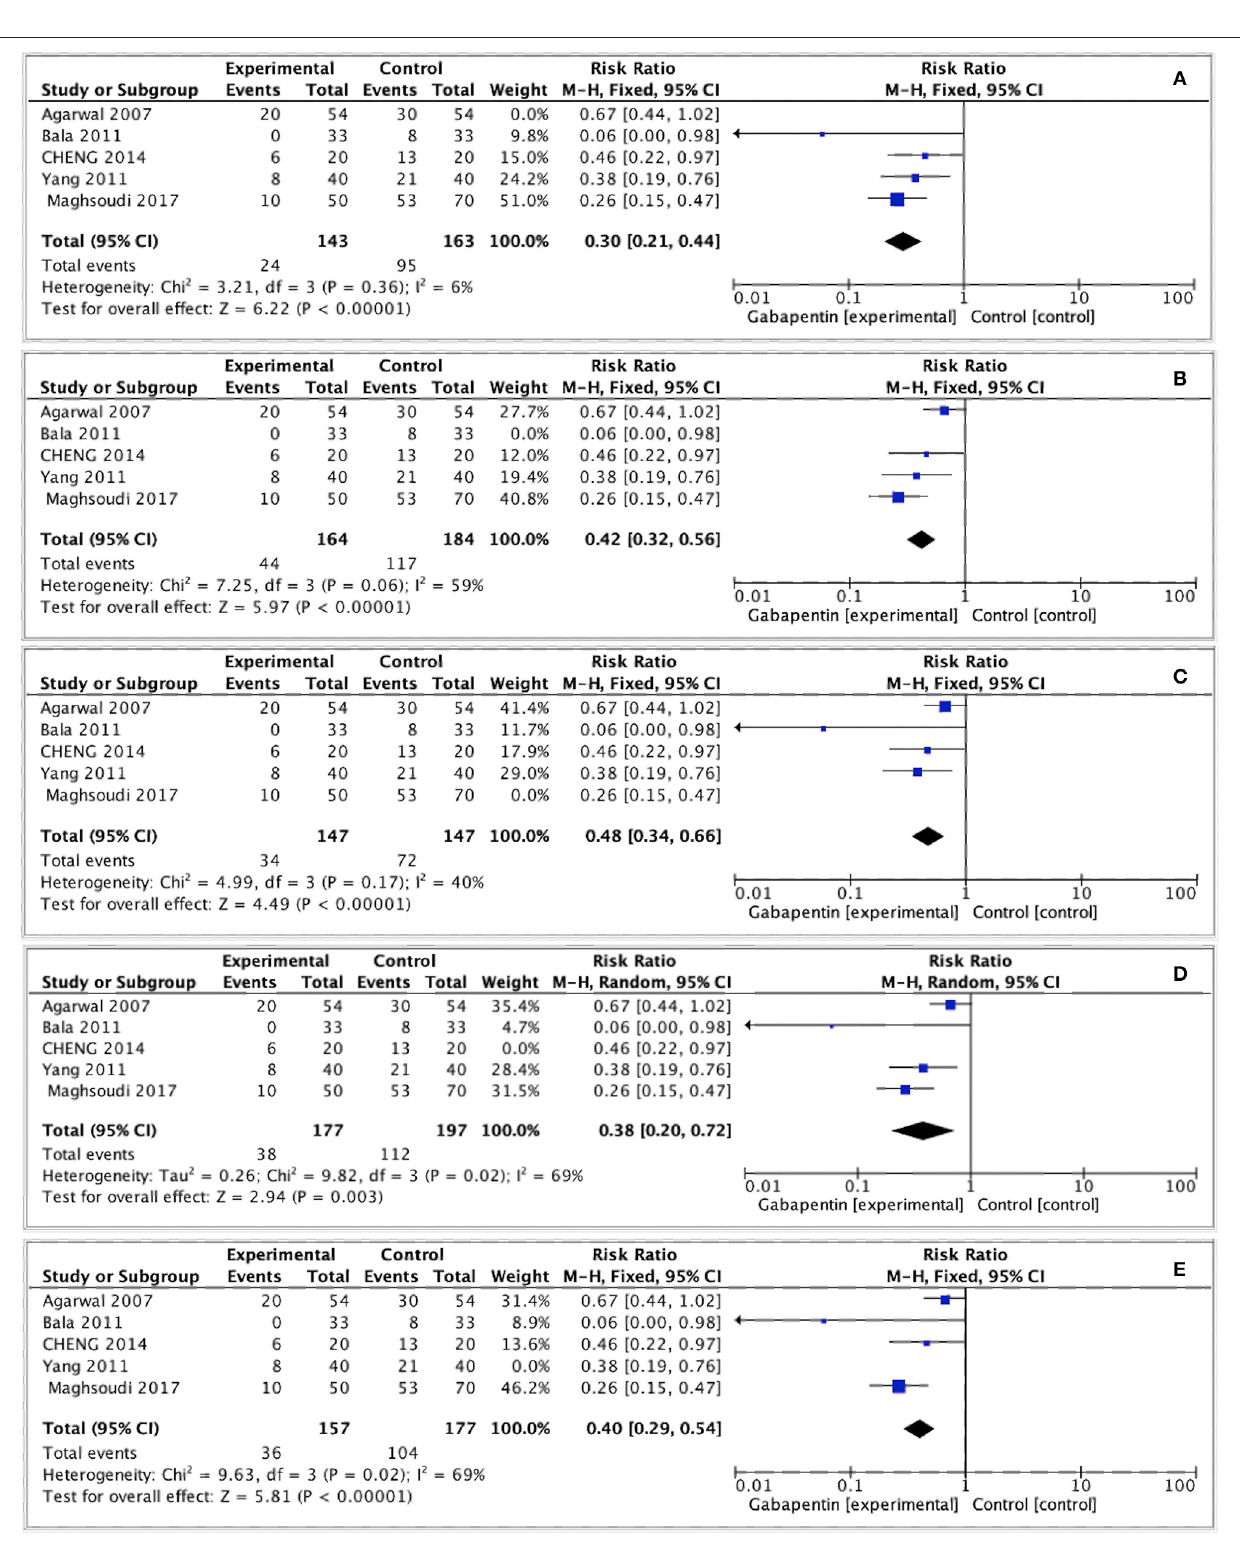
Frontiers in Surgery |